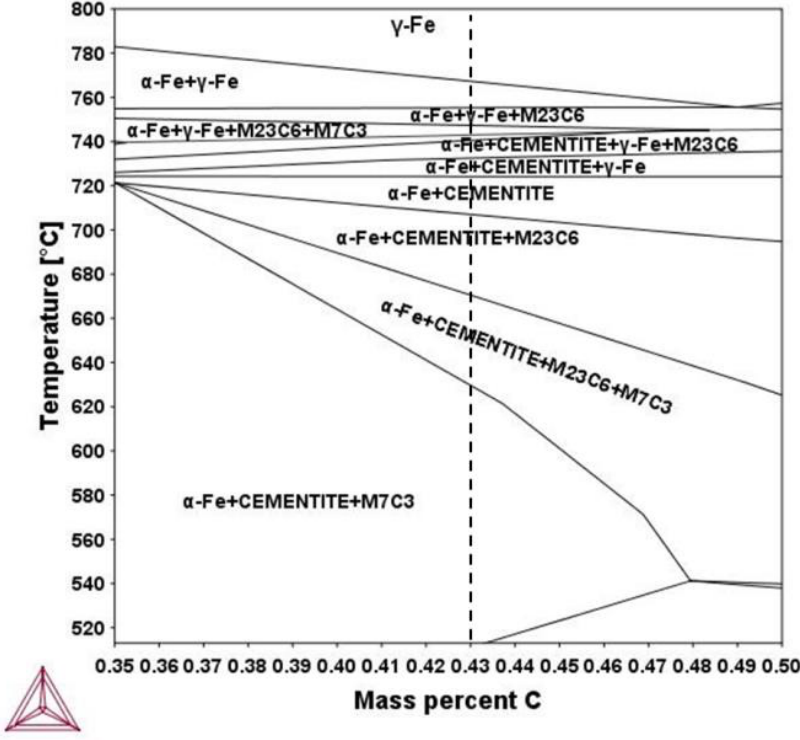
Figure 1. Isopleth of the phase diagram of CrMo steel calculated using Thermocalc ® software. The dashed line indicates the carbon (C) content.